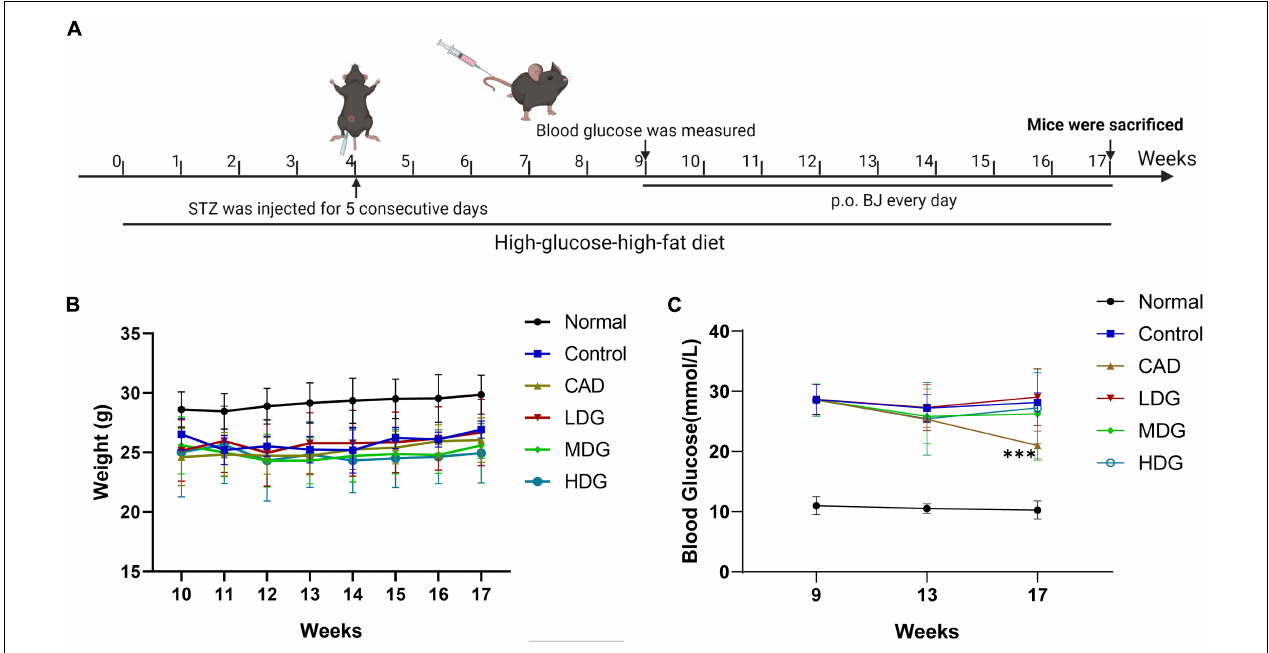
FIGURE 2 | Effect of BJ on the bodyweight and blood glucose in diabetic mice. (A) In vivo experiment process. Mice were fed a high-fat–high-glucose diet for 17 weeks. In the 4th week, mice were intraperitoneally injected with 50 mg/kg STZ for 5 consecutive days. In the 9th week, mice with blood glucose concentration above 16.7 mmol/L were considered type 2 diabetic. BJ was given for 8 consecutive weeks. Mice were weighed once a week (B) , and in the 13th and 17th week, the blood glucose was measured (C) . Data are represented as means ± SD ( n = 8). ∗∗∗ P < 0.001 vs. control.